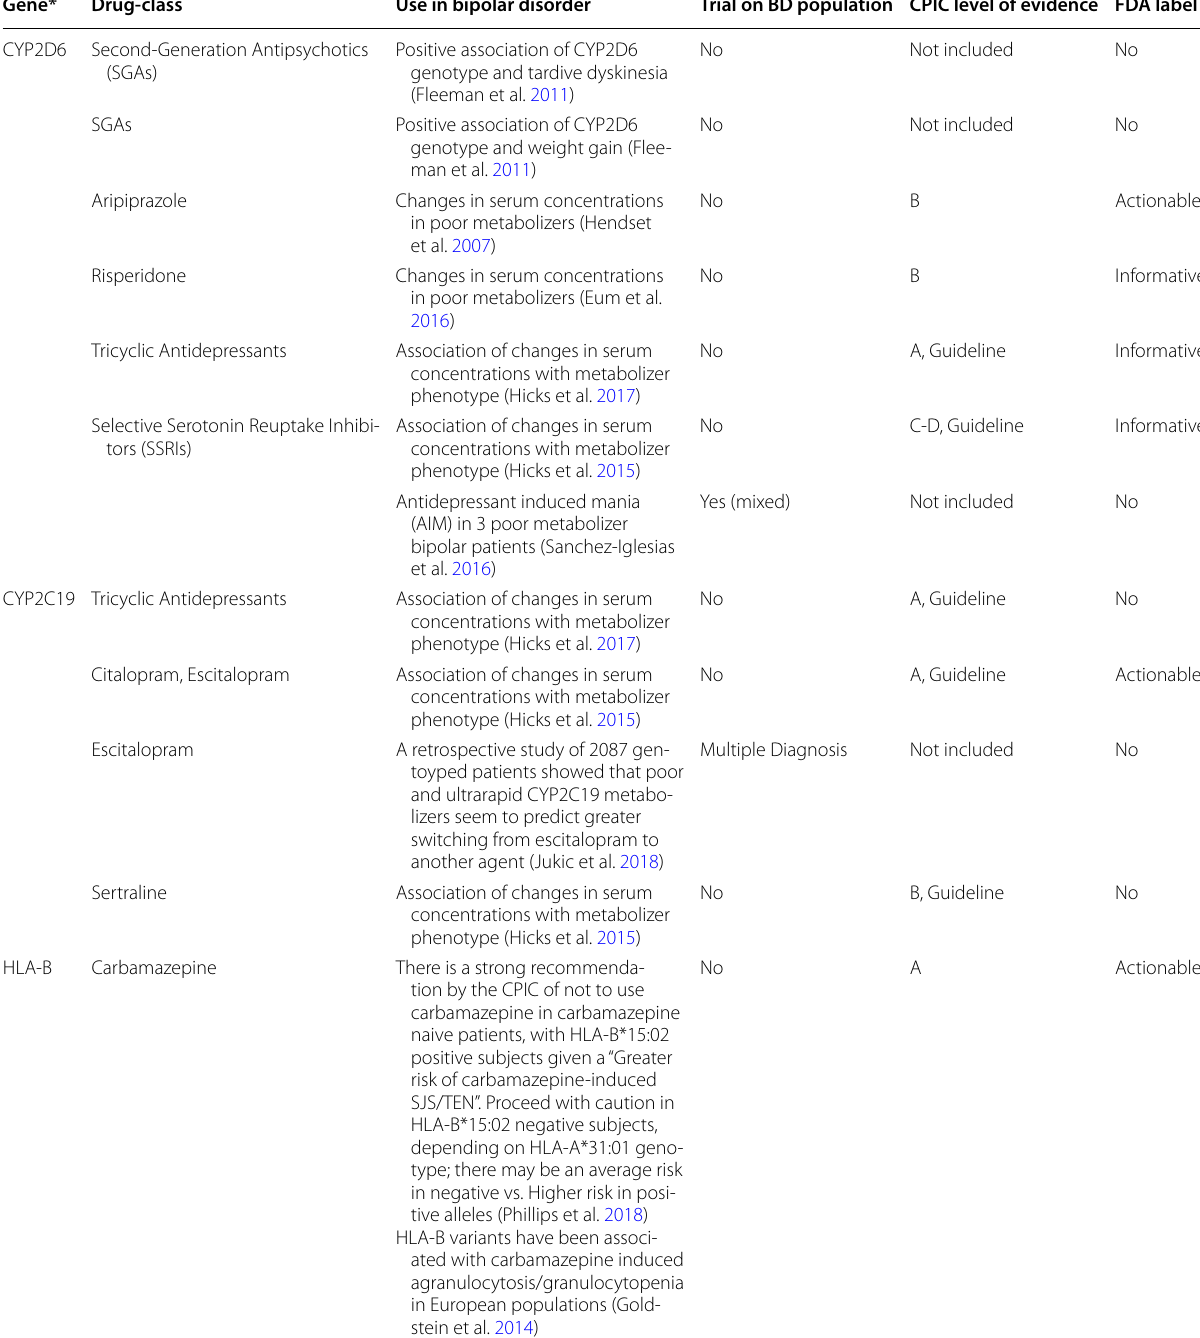
Table 1 Potential content of commercial PGT